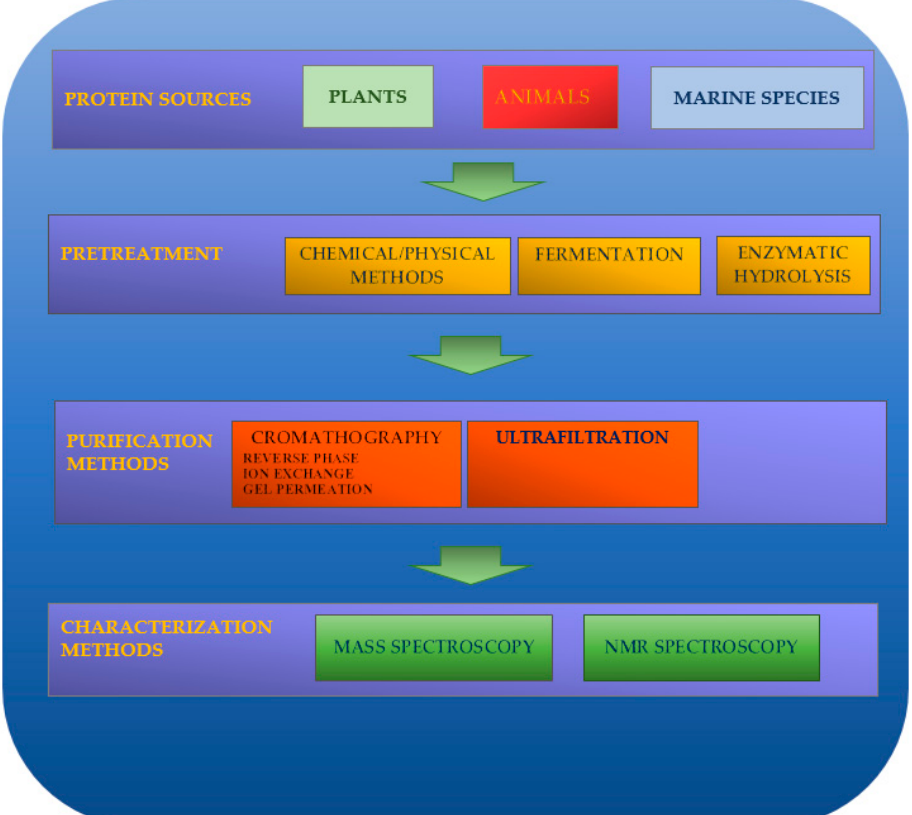
Figure 1. N atural peptides' production. Figure 1. Production of natural